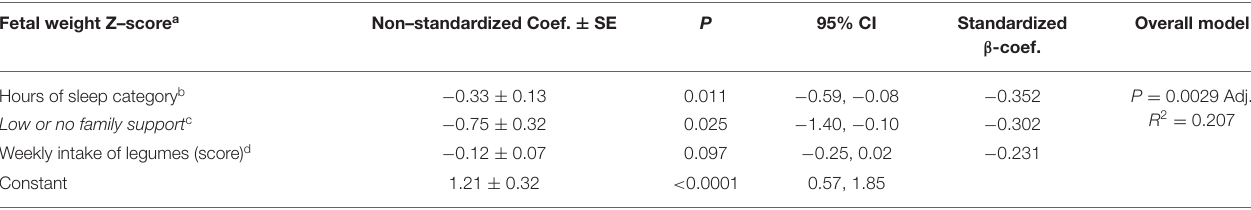
TABLE 6 | Multiple linear regression model for sonography-estimated fetal weight Z scores. Fetal weight Z–score